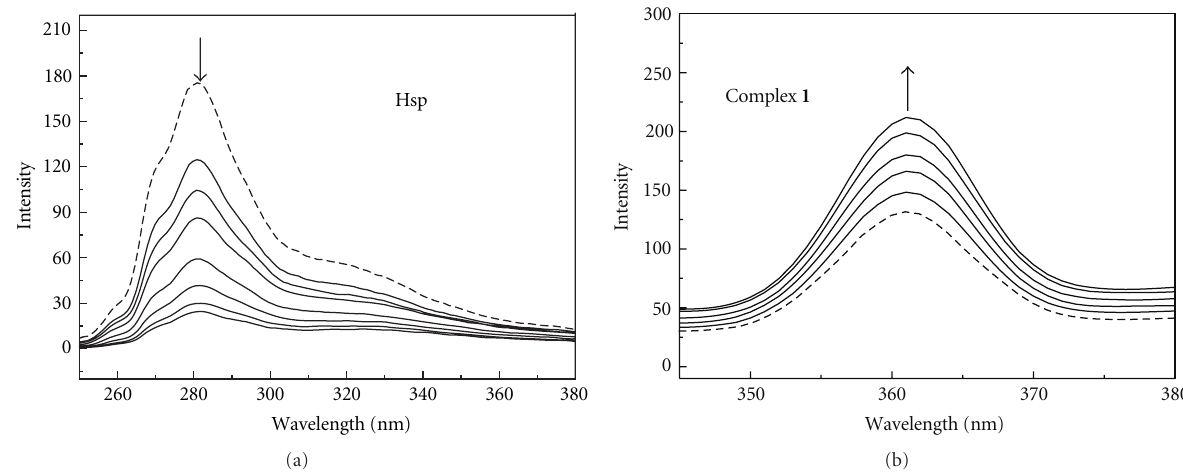
Figure 4: Emission spectra of Hsp and 1 in the absence (----) and presence (—) of increasing amounts of DNA.